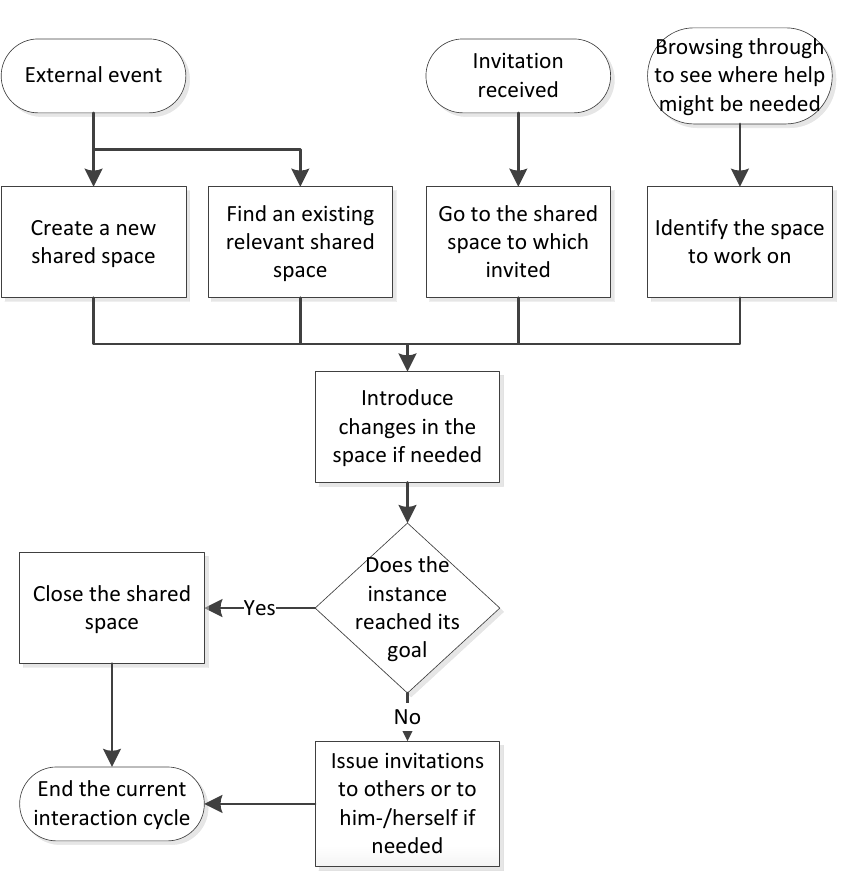
Figure 2. Simplified flowchart that explains functioning of a BPS with shared